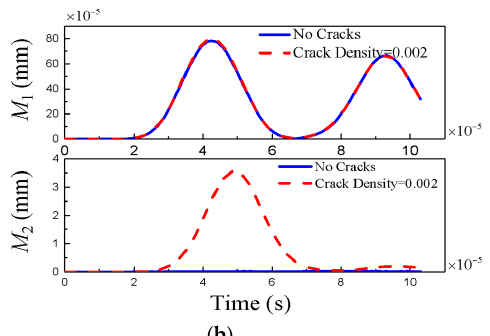
Figure 8. Lamb waves collected at position 1 in the z -direction. ( a ) The time domain; ( b ) the spectrum graph sliced at the fundamental frequency 0.52 MHz and second harmonic frequency 1.04 MHz ( c = 0.002, μ = 0.3).